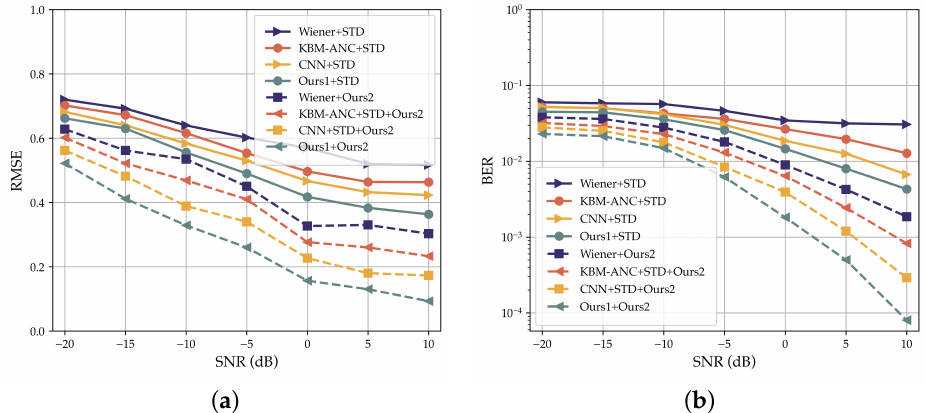
Figure 19. Comparison of RMSE and BER performance between various joint algorithms: ( a ) the RMSE performance comparison between various joint algorithms; ( b ) the BER performance compari- son between various joint